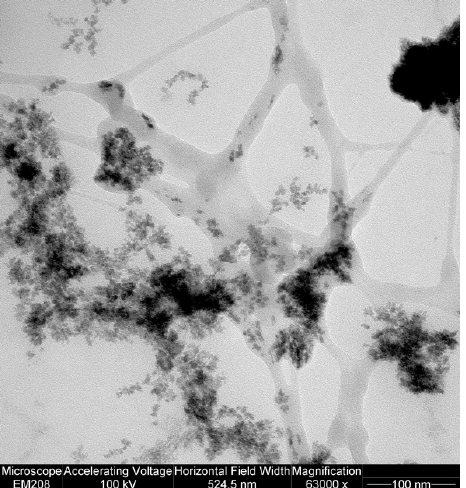
Figure 4. Transmission electron microscope (TEM) picture of hydrogel 20B. Gray ribbons represent polyvinylpyrrolidone (PVP) chains (the contrast agent weakly colors PVP chains), while dark zones represent crosslinked alginate strongly colored by the contrast agent.